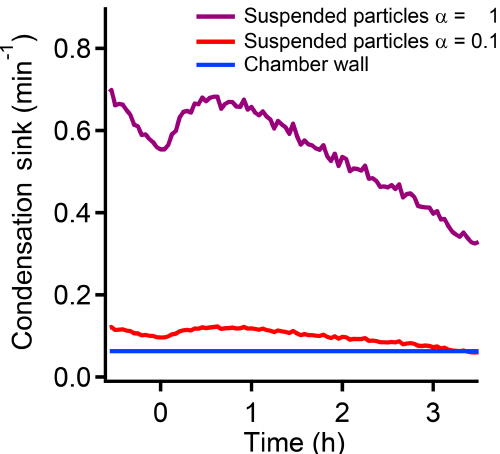
Figure 6. The difference of the condensation sink between the chamber wall with the suspended particles when the mass accom- modation coefficient is 0.1 or 1. When α = 1, the condensation sink of the suspended particles is much larger than the wall condensation sink. When α = 0.1, the two values are on a similar level, which in- dicates that the vapor wall loss may be very